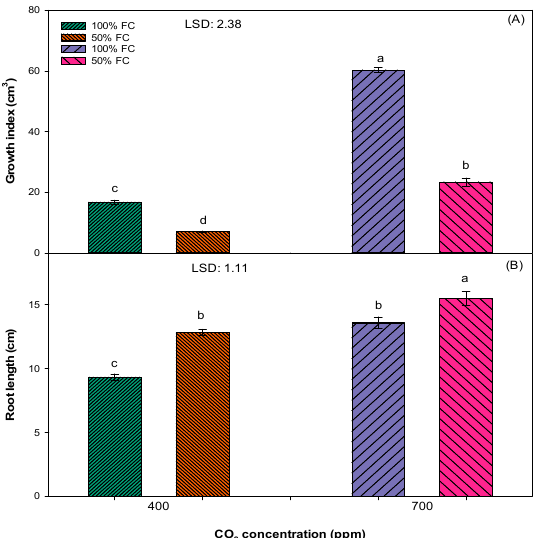
Figure 1. Effect of different [CO 2 ] and soil moisture levels on ( A ) plant height and ( B ) leaves per plant of S. cannabina recorded at harvest. The experiment was repeated, and the pooled data from the two studies are presented here. The vertical bars represent error bars ( n = 12). LSD represents the least significance difference ( p ≤ 0.05; n = 12). Different letters (a, b, c, d) on the error bars indicate significant differences, as determined by Fisher’s protected LSD test at p < 0.05. The abbreviation FC in the figure represents the field capacity.